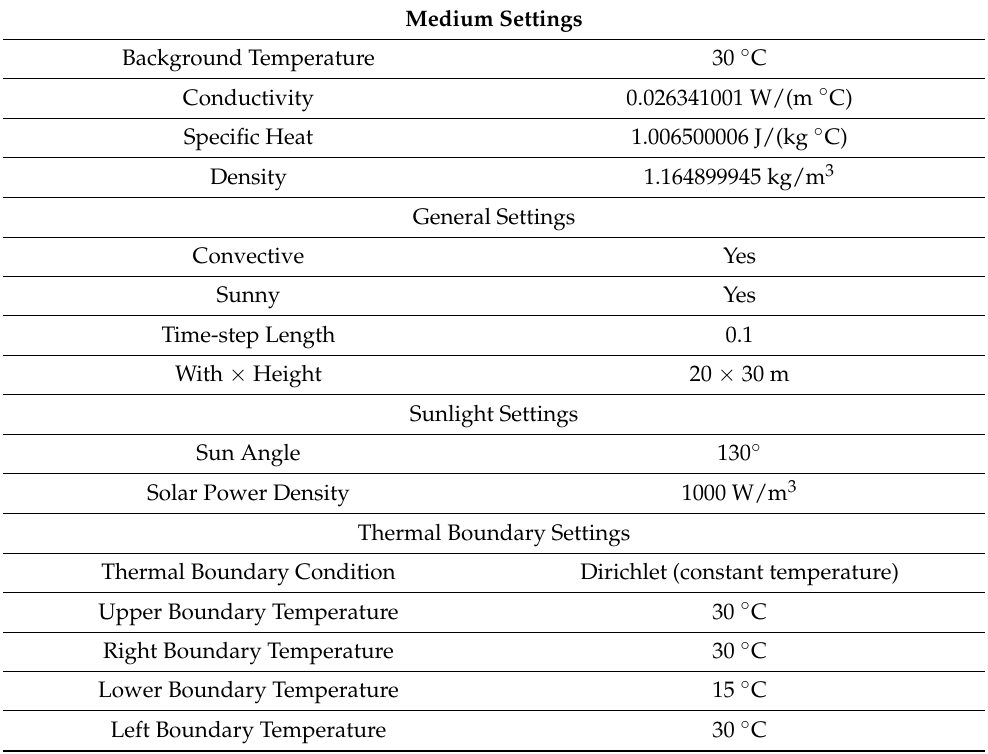
Table 3. Properties settings for the simulation in Energy2D.